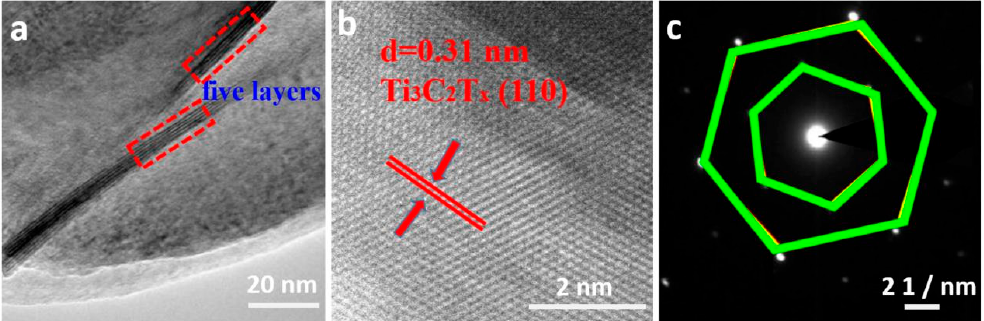
Figure 5. ( a ) TEM image of Ti 3 C 2 T x nanosheets, ( b ) HRTEM image of Ti 3 C 2 T x nanosheets, and ( c ) selected-area electron diffraction (SAED) of Ti 3 C 2 T x nanosheets.